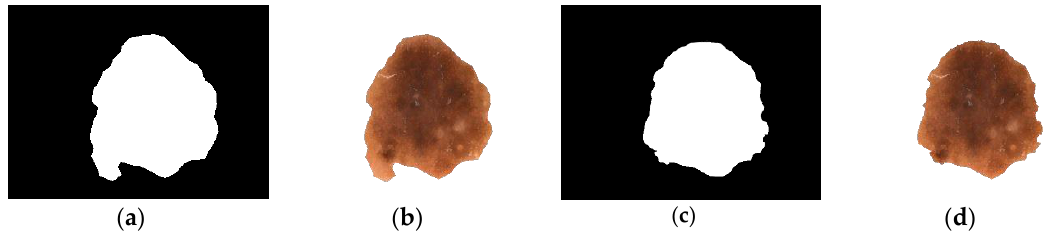
Figure 8. Sequential output of the two phase iteration segmented process. ( a ) Segmented lesion area of iteration I, ( b ) segmented output of iteration I, ( c ) segmented lesion area of iteration II, ( d ) final output of iteration II .